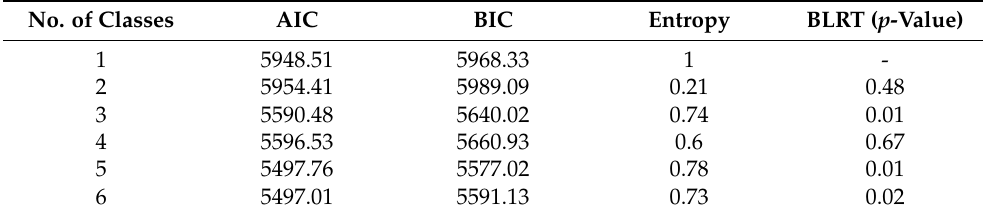
Table 2. Summary of Information for Selecting the Number of Latent Classes for Latent Profile Anal- ysis.